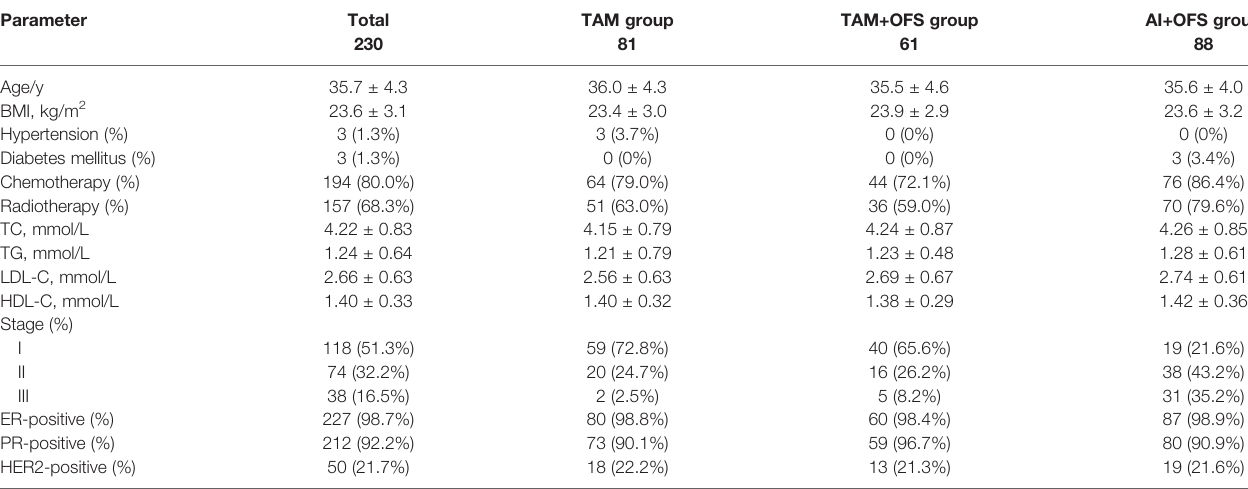
TABLE 1 | Basic characteristics of the included patients. Parameter